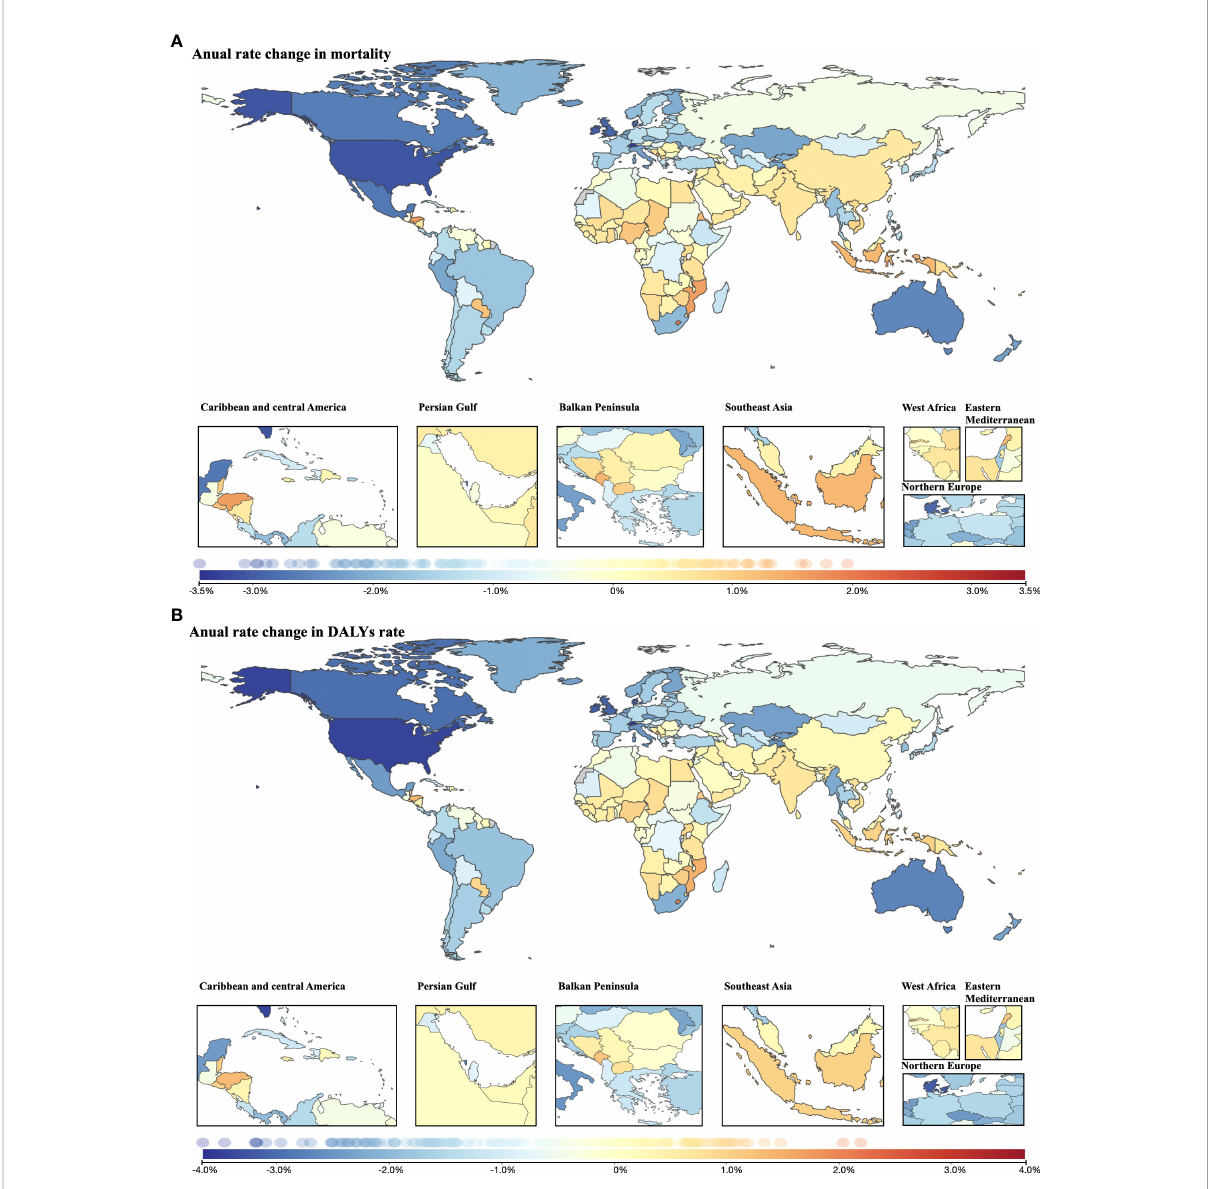
FIGURE 6 Annual rate change in cancer burden attributable to secondhand smoke for both sexes combined from 1990 to 2019. (A) Annual rate change in mortality; (B) annual rate change in DALYs